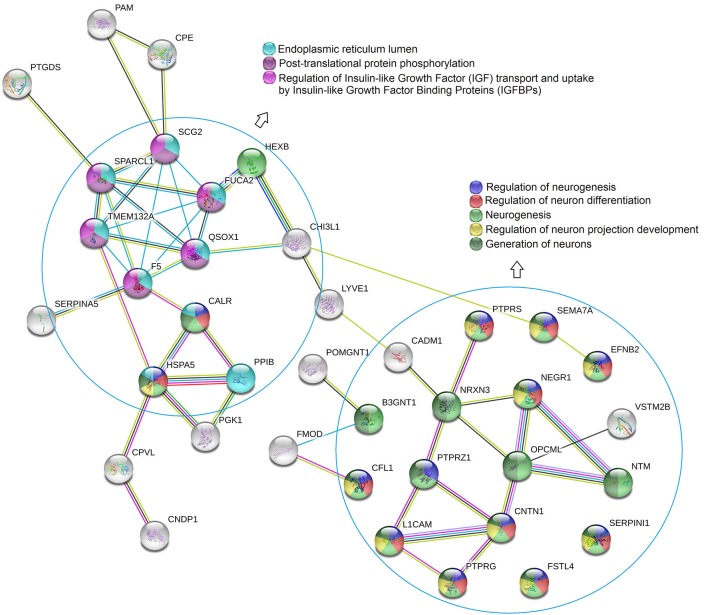
STRING protein-protein interaction diagram. GO and pathway enrichment analysis revealed that a cluster of proteins were involved in biological processes of neurogenesis, neuron differentiation, and neuro project development. Another cluster of proteins which were located in endoplasmic reticulum lumen, were involved in the pathways of post-translational protein phosphorylation, regulation of insulin-like growth factor (IGF) transport and uptake by insulin-like growth factor binding proteins (IGFBPs).